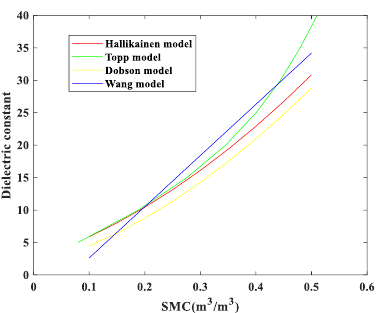
Figure 9 . The four soil models on international silty sandy loam （ C=0.07 ， S=0.7 ） .